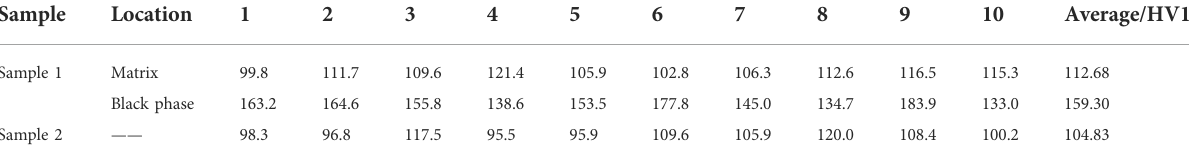
TABLE 3 Microhardness at each area of alloys obtained by melting the circuit board sample 1 and pure metals sample 2.